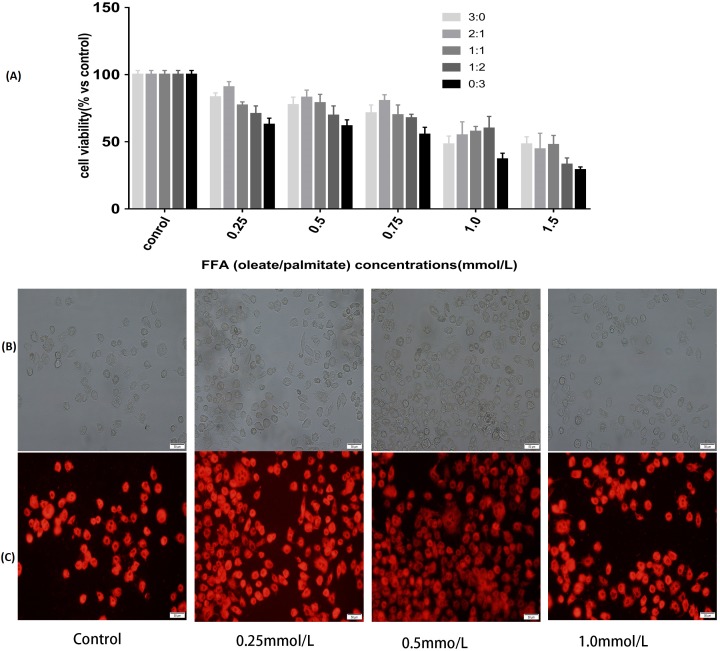
Effects of FFA on cell viability and lipids accumulation in L-02 cells.(A) L-02 cells were treated with FFA mixture at various ratios (oleate/palmitate at 3:0, 2:1, 1:1, 1:2 and 0:3 ratio) and concentrations (0.25, 0.5, 0.75, 1.0 and 1.5 mmol/L) for 24 h. Cell viability was determined by a Cell Counting Kit 8 (CCK8) kit. The viability of the L-02 cells incubated with FFA mixed at a ratio of 2:1 (oleate/palmitate) was higher than that for the other ratios in FFA lower than 1.0 mmol/L groups (P < 0.05). The viability of the L-02 cells incubated with 0.25, 0.5, 0.75 and 1.0 mmol/L of the FFA mixture (oleate/palmitate) were all higher than those incubated with 1.5 mmol/L of the FFA mixture (P < 0.05). (B) The white light microscopic image of lipid dropets. (C) The fluorescent microscopic image of lipid dropts (dyed red in Nile Red staining). The FFA mixture of 0.5 mmol/L with sodium oleate and sodium palmitate mixed a ratio of 2:1 had higher lipid accumulation rate (P < 0.05).